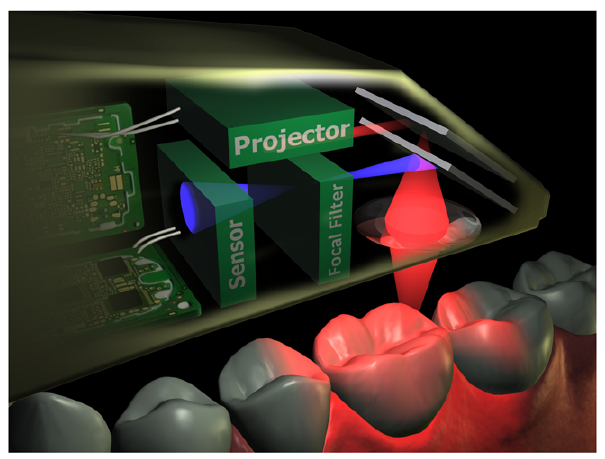
Figure 4. The hi-res scanning protocol for the Lava COS scans. The scanning protocol for the scans for the Lava COS is the normal scanning protocol, except that the scan-path is a slow zigzag scan and that at the end of the scan a second calibration is